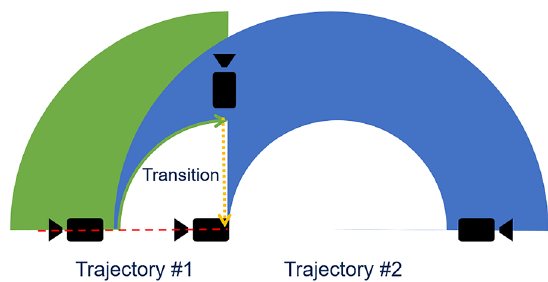
Fig. 10 The concept of the dataset creation method in trajectory design. Green: Trajectory #1; Orange: Transition; Blue: Trajectory